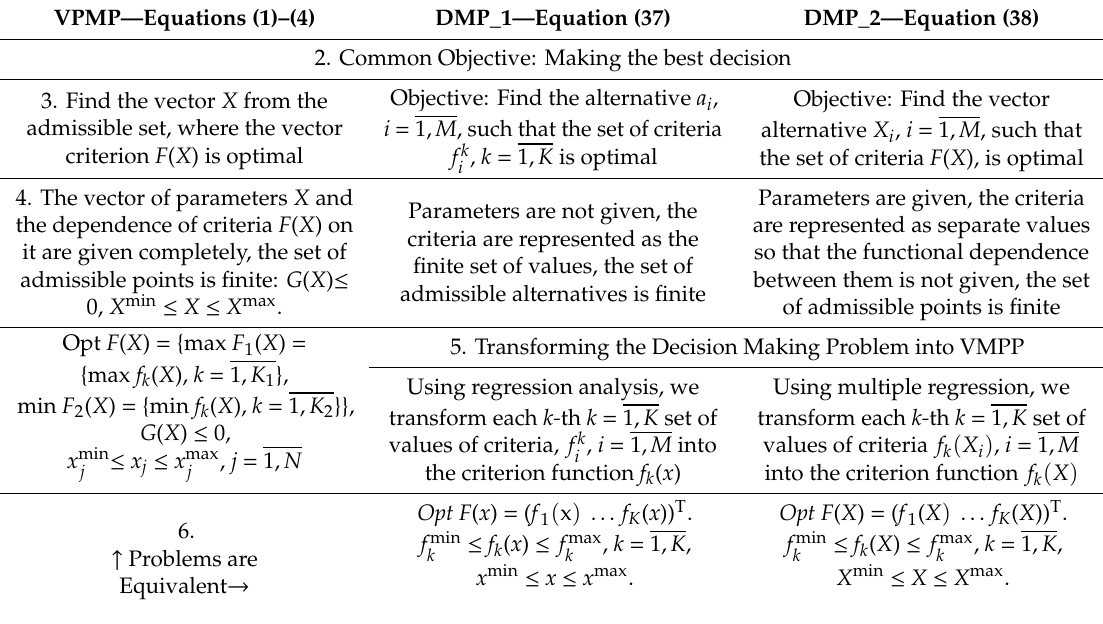
Table 2. Comparing vector problem mathematical programming (VPMP) to decision-making problems